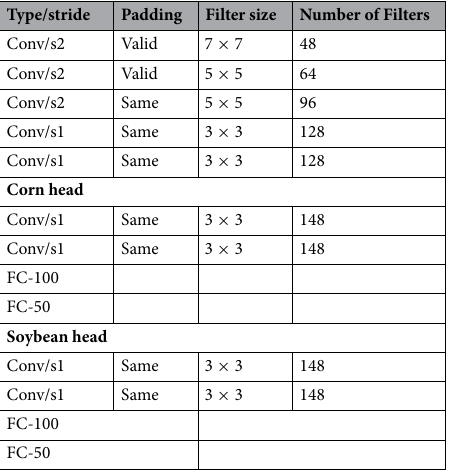
Table 1. YieldNet architecture. The first five convolutional layers work as a backbone feature extractor and share weights for both corn and soybean yield